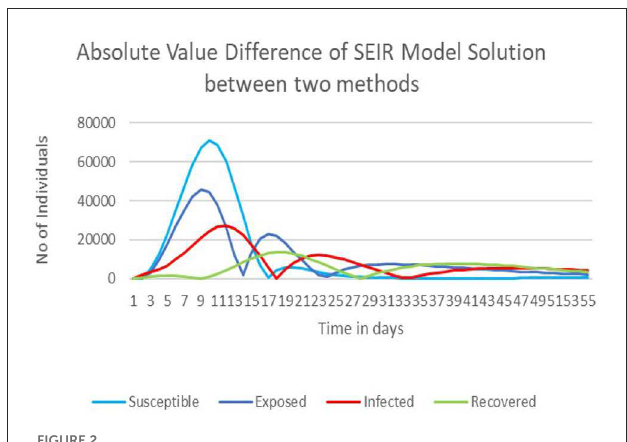
FIGURE2 The absolute value difference of SEIR model solution between two